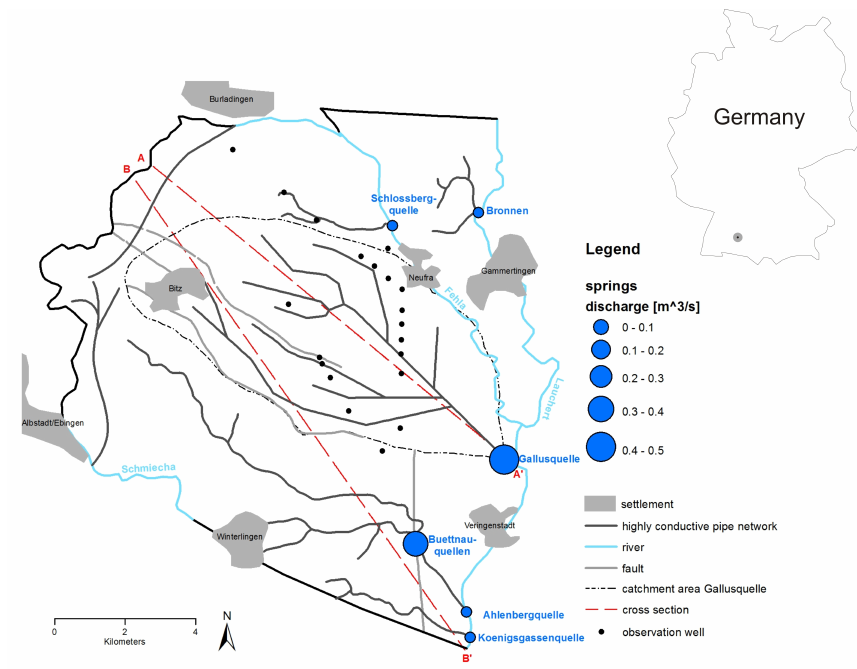
Fig. 2. Model area, including the catchment of the Gallusquelle spring and positions of all simulated springs. The highly conductive elements feeding the Gallusquelle spring were modeled after Doummar et al. (2012) and the ones along the dry valleys after Gwinner et al.